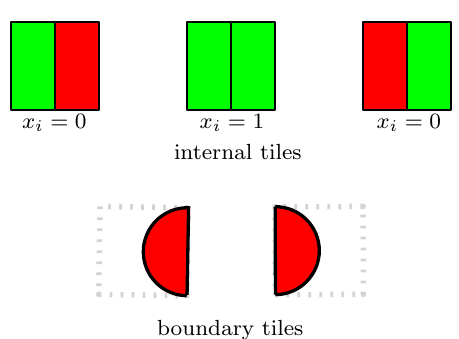
Figure 8. The set of the good tiles for the case k = 1.